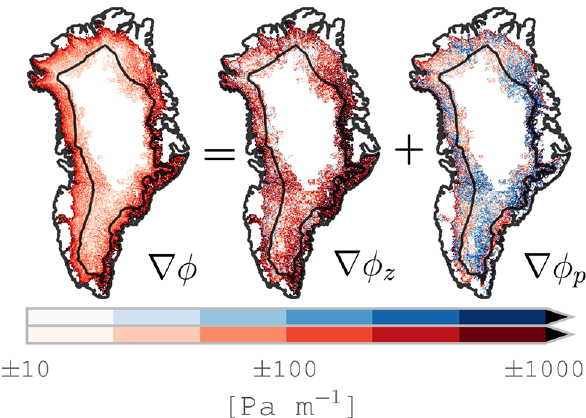
Figure 2. Net hydropotential gradient for each cell ( ∇ φ ) and the de- composition of net hydropotential gradient to elevation-driven hy- dropotential gradient ( ∇ φ z ) and pressure-driven hydropotential gra- dient ( ∇ φ p ). Red implies flow downhill or under thinning ice. Blue implies flow uphill or under thickening ice. Black lines are sea level and 2000m contour.